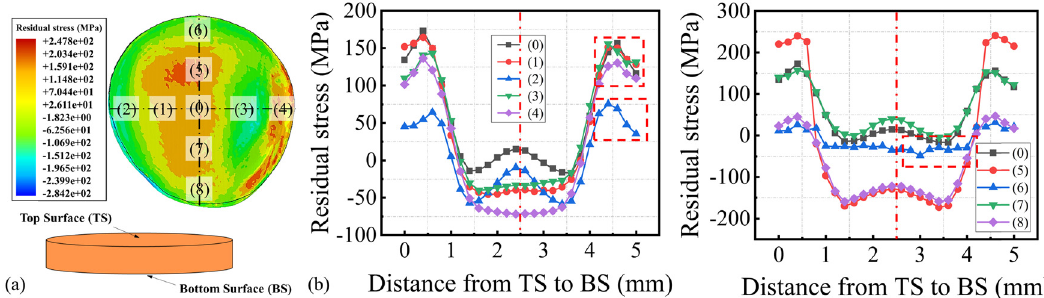
Figure 5: ( a ) Residual stress distribution in the planar direction on top surface and ( b ) residual stress distribution in the thickness direction for the typical locations in ( a )